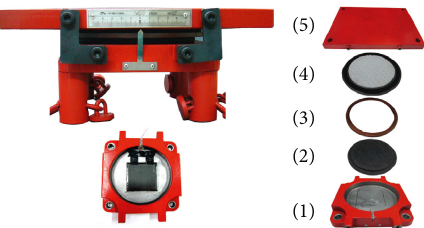
Figure 2: Layup configuration of multilayered d